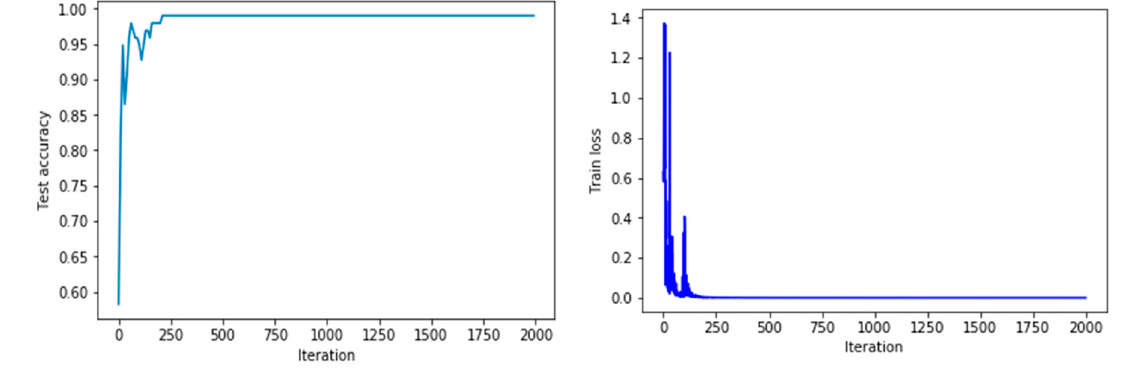
Figure 6. Trend of Prediction Accuracy and Error Rate with LSTM Learning. ( a ) Prediction accuracy with number of iterations, ( b ) Error rate with number of iterations.